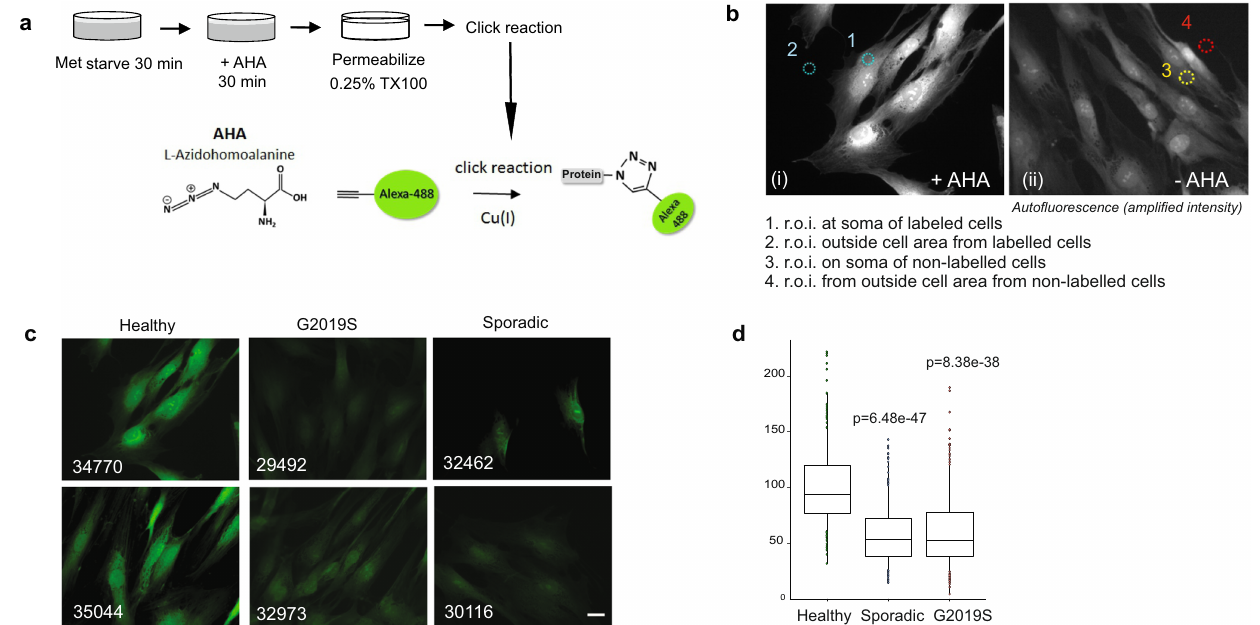
Fig. 1 Bulk protein synthesis is reduced in Parkinson ’ s disease patient fi broblasts. a Schematic of metabolic labeling. b Scheme illustrating how regions of interest (r.o.i.) were positioned for measuring soma and background fl uorescent intensities. Representative images of cells with ( + AHA) and without AHA (-AHA) label are shown (i, ii). The brightness of image i is enhanced in order to see the auto fl uorescence which would otherwise not be visible by eye. Image acquisition settings were constant throughout. c Representative images of AHA-labeled fi broblast cells from G2019S or sporadic PD patients or healthy controls and their NINDS repository ID are shown. Scale indicates 20 µm. d Mean fl uorescence intensities after background and auto fl uorescence intensity subtraction are shown from healthy, G2019S and sporadic cases. Adjusted p -values were calculated using Student ’ s t -test and corrected with Benjamini and Hochberg method. Box plots depict 50% of middle values from bottom 25% percentile to top 75% percentile, with a line showing the median values. Whiskers show values at 1.5 times the interquartile